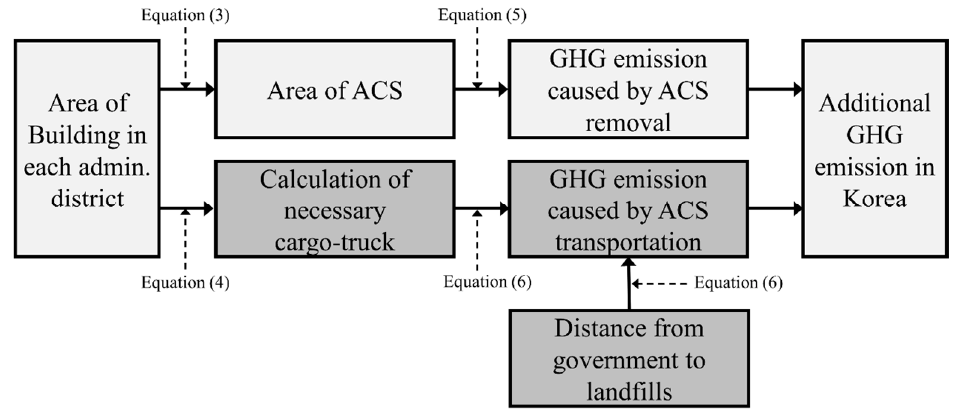
Figure 5. Flow chart representing the process of calculating GHG emission produced by ACS removal in the entire country of Korea.